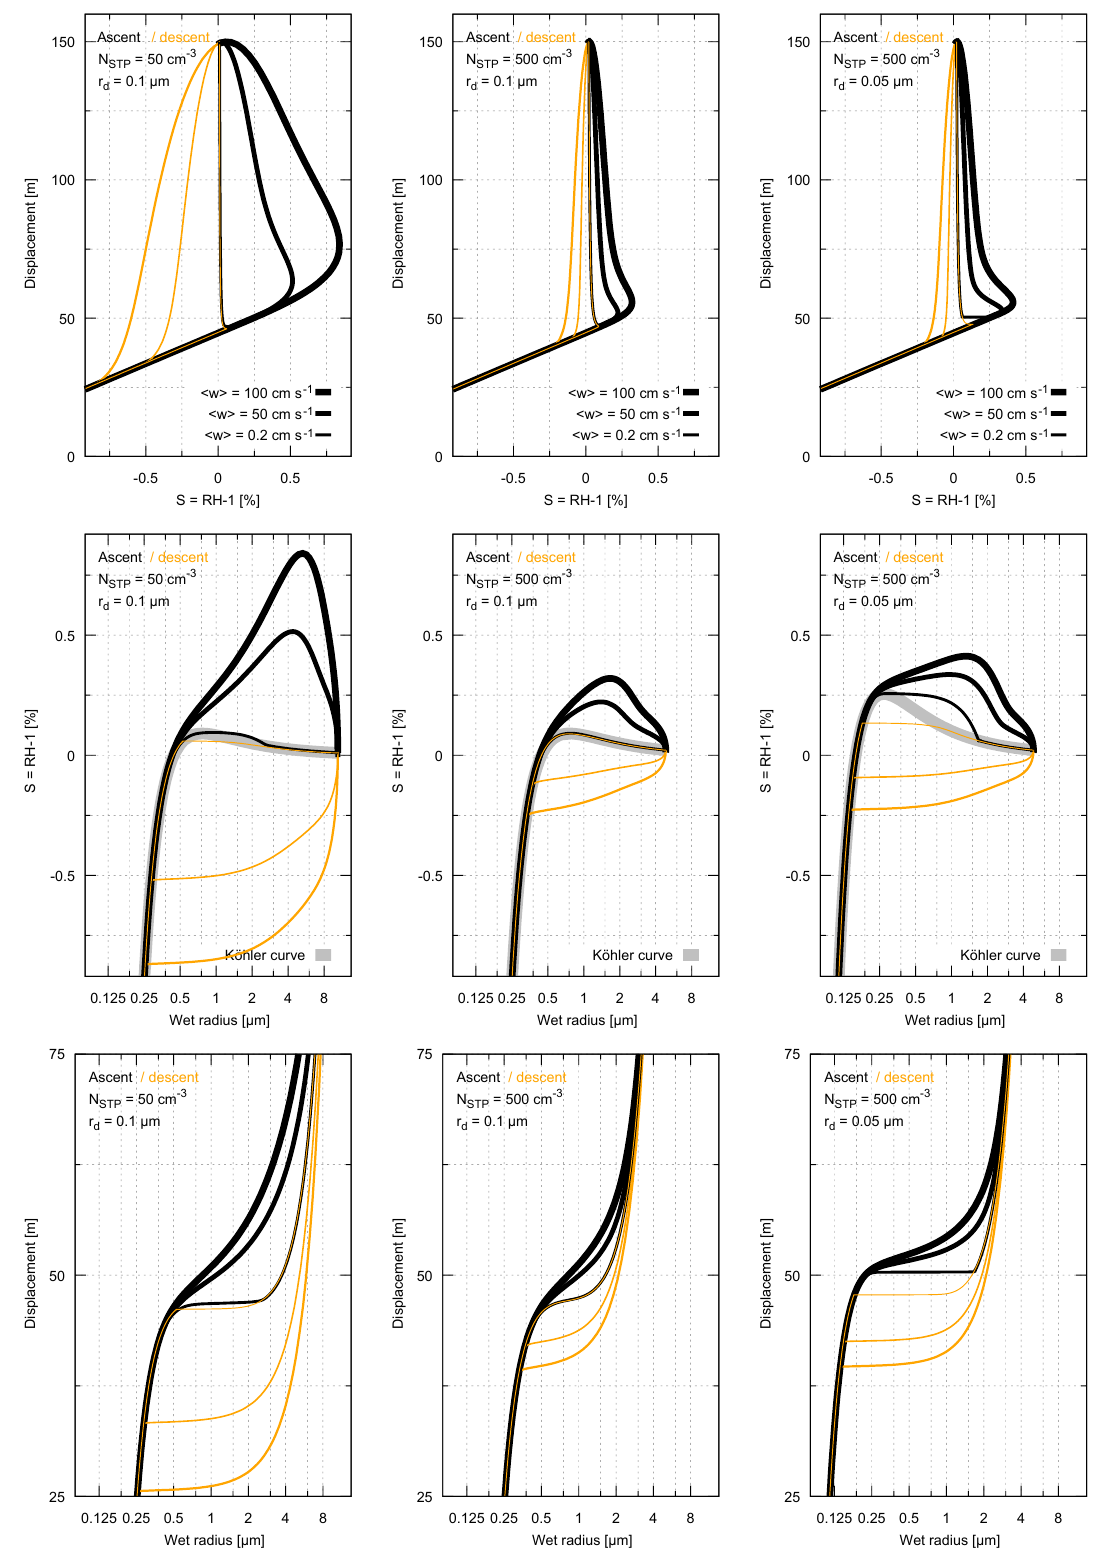
Figure 5. Results of numerical simulations discussed in Sect.